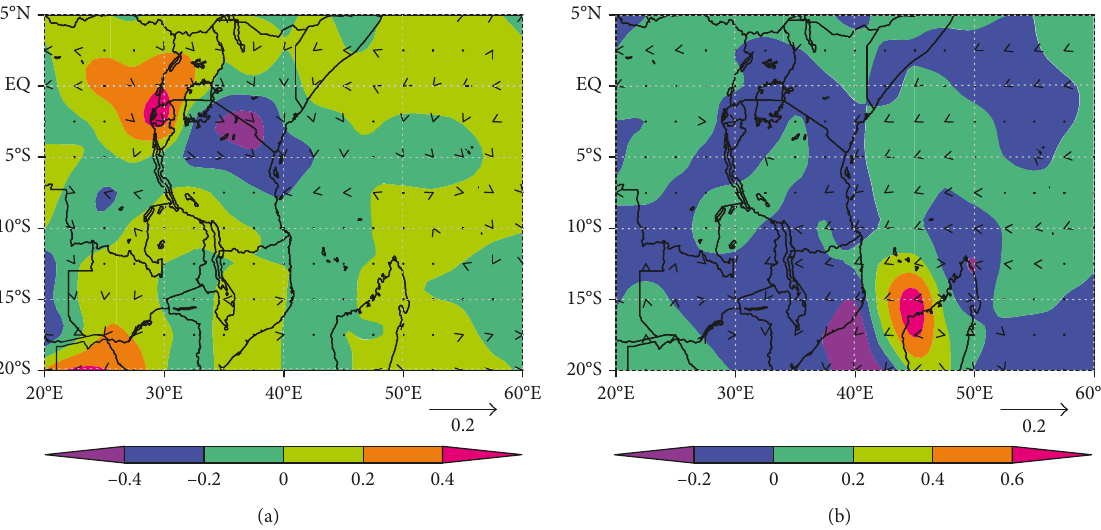
Figure 7: The 850 hPa composite anomaly fields of the moisture flux (vectors) and its divergence (shading) during (a) anomalous HREs and (b) suppressed HREs, where positive and negative shading represents divergence and convergence, respectively. The scale vector cor- responds to moisture flux 0.2g/kg m/s, and the moisture flux divergence contour interval is 0.2 ·